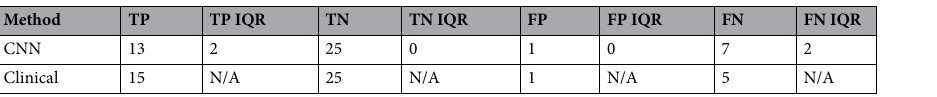
Table 1. The amount of true positives (TP), true negatives (TN), false positives (FP) and false negatives (FN) with median and interquartile range (IQR) of the CNN on 100 runs of the data in addition to the results with the clinical interpretation with the hold-out (test)